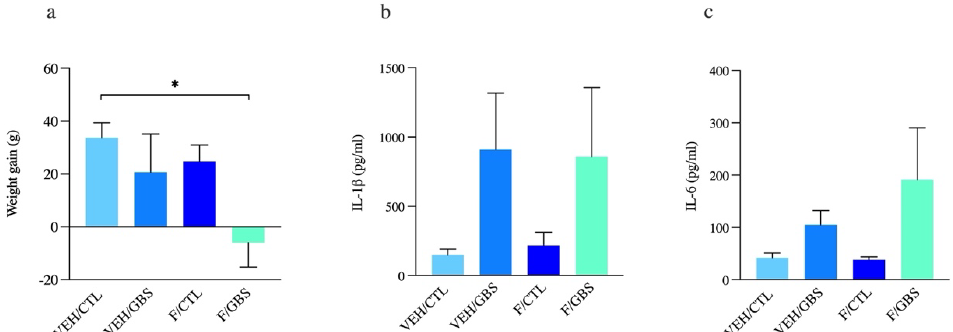
Figure 2. Monitoring of maternal weight and pro-inflammatory response in the blood circulation. Mean maternal weight gain from G18–22 ( a ). Mean concentrations of IL-1 β ( b ) and IL-6 ( c ) in maternal sera. Analyses were done by one-way ANOVA with Tukey’s multiple comparison (maternal weight gain, IL-1 β ) or Kruskal-Wallis with Dunn’s multiple comparison test when data was not normally distributed (IL-6). Bars represent mean ± SEM. Number ( n ) of dams in vehicle/control: n = 6, vehicle/GBS: n = 5, flutamide/control: n = 5, flutamide/GBS: n = 5. * p < 0.05.